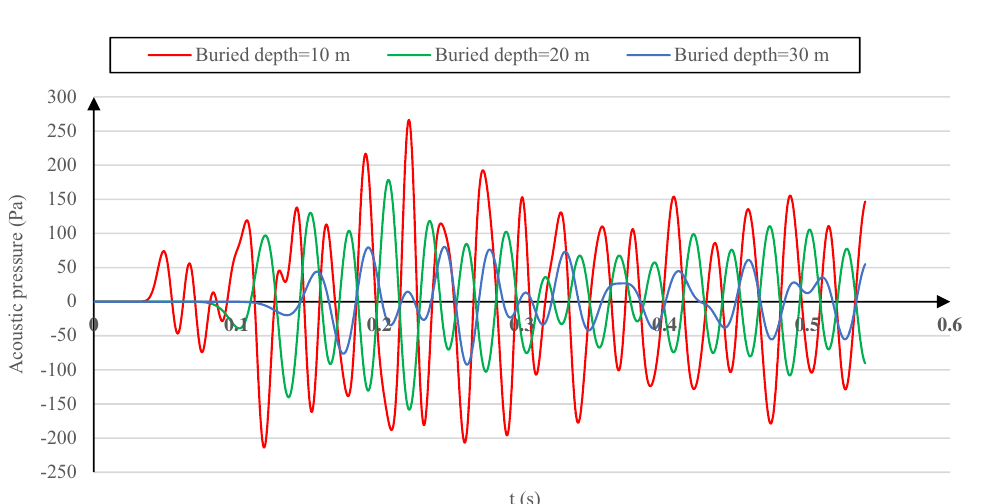
Figure 8. Transmitted acoustic wave pressure time histories for the cases of 10-m, 20-m and, 30-m buried depth with reference soil